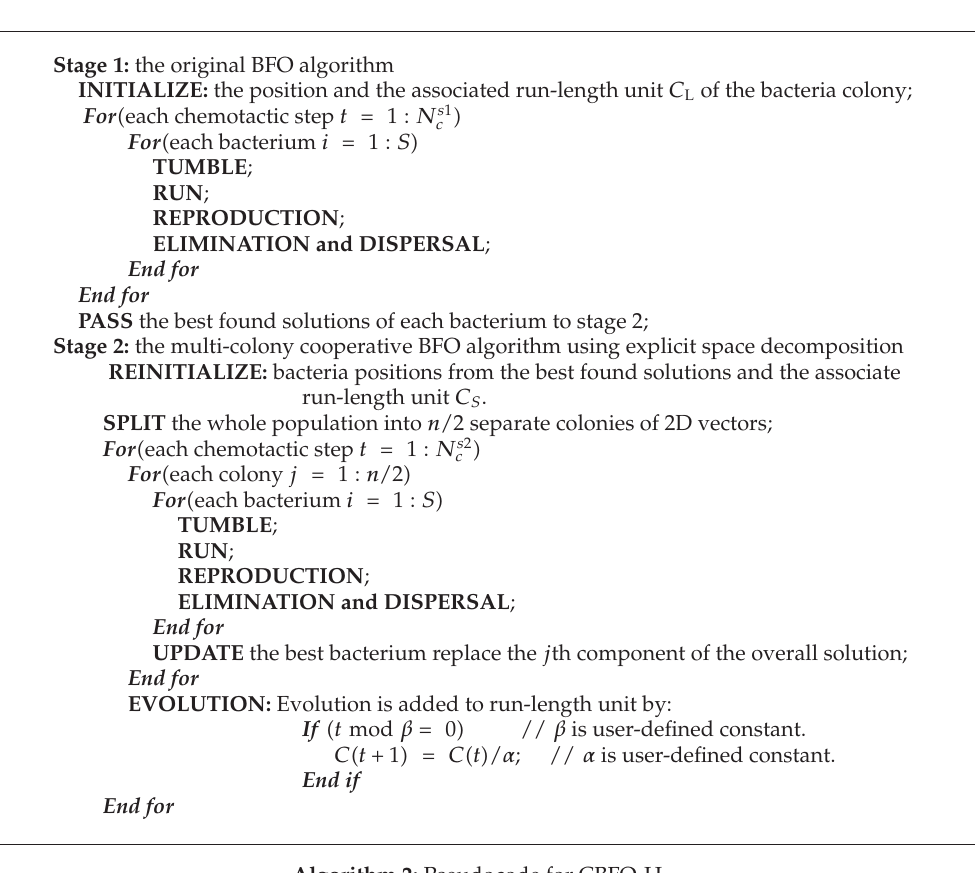
Algorithm 2: Pseudocode for